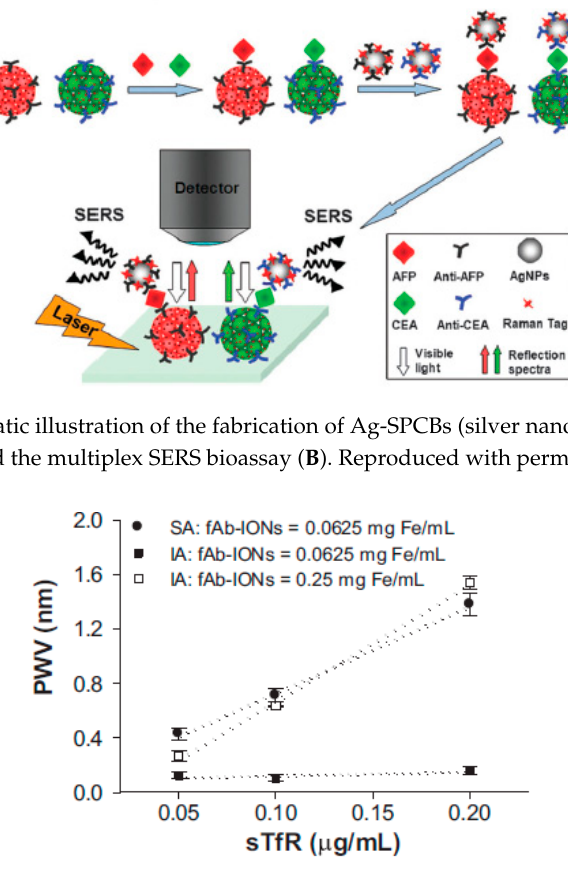
Figure 19. Comparison of linear responses when using inverse sandwich assay (IA) at 0.0625 and 0.25 mg Fe/mL with the standard assay (SA) at 0.0625 mg Fe/mL to measures transferrin receptor (TfR) on the 3DOCs biosensor. Iron-oxide nanoparticles with antibodies: fAb-IONs. PWV: peak shift. Responses were measured at 200 min. Reproduced with permission from [44].